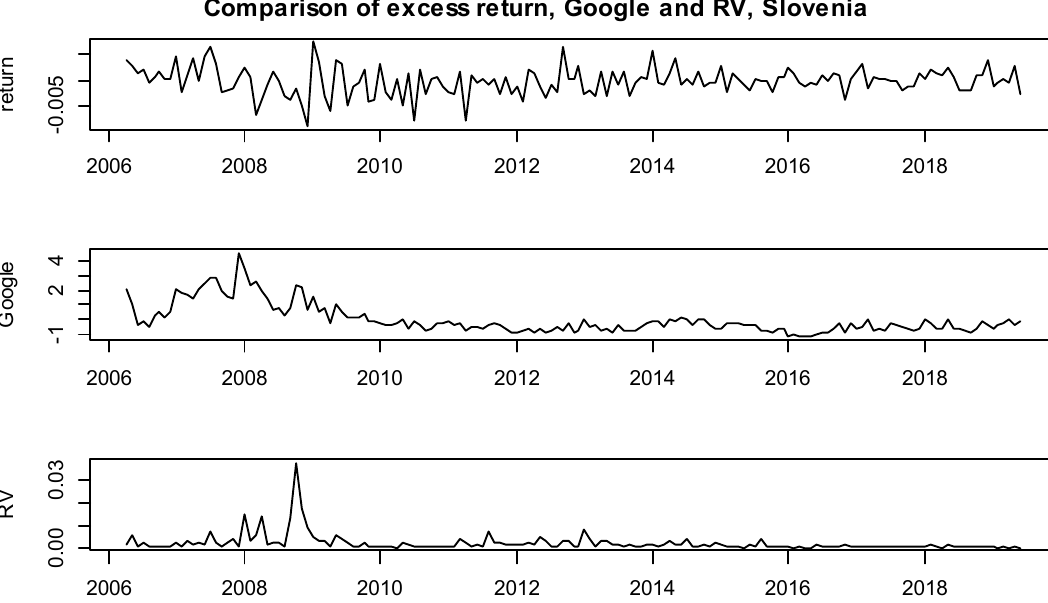
Figure A7. Comparison of monthly series: Excess return, RV and Google search volume, Slovakia.